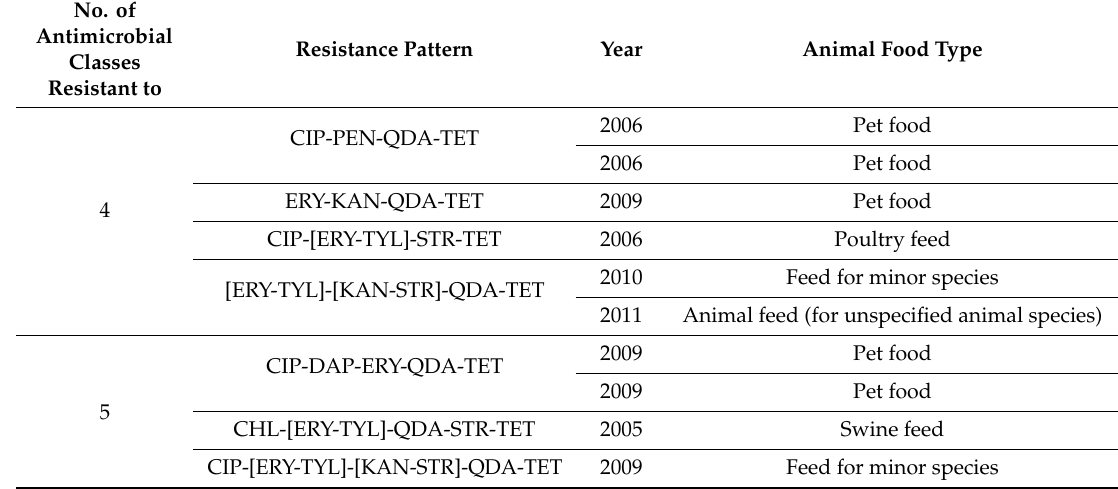
Table 5. Multidrug-resistant E. faecium isolates that were resistant to 4 or 5 antimicrobial classes. No.